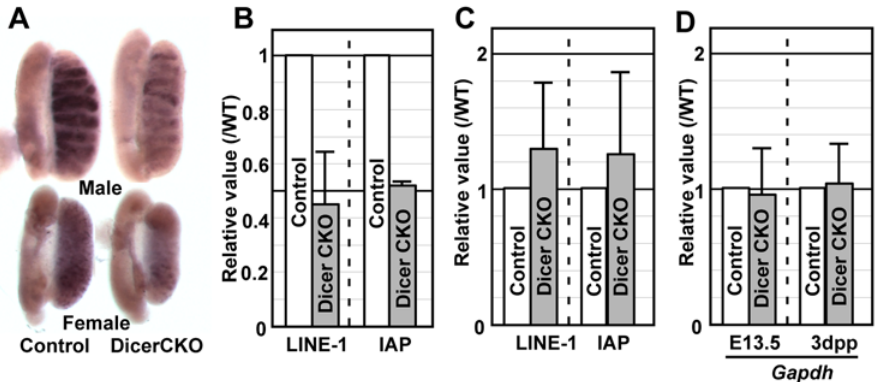
Figure 3. Lower expression of IAP and LINE-1 in DicerCKO PGCs. (A) In situ hybridization analysis of LINE-1 expression in E13.5 gonads. The signal was presumably detected in both male (upper) and female (bottom) germ cells. (B–C) Real-time PCR analysis of IAP and LINE-1 expression in E13.5 PGCs (B) and in neonatal spermatogonia (C). Shown are relative values of transcript levels of LINE-1 or IAP in DicerCKO, compared to those in littermate controls. (D) Real-time PCR analysis of Gapdh expression in E13.5 PGCs (E13.5) and neonatal spermatogonia (3dpp) in DicerCKO, compared to those in littermate controls. Shown are relative values of transcript levels of Gapdh in DicerCKO, compared to those in littermate controls. Same number of sorted PGCs from control and mutant embryos (3000 PGCs) were subjected to cDNA synthesis, followed by Q-PCR analysis. The value for Gapdh transcripts was calculated by using a reference graph generated from serially diluted DNA samples. The mean values in DicerCKO cells were calculated from three independent experiments.